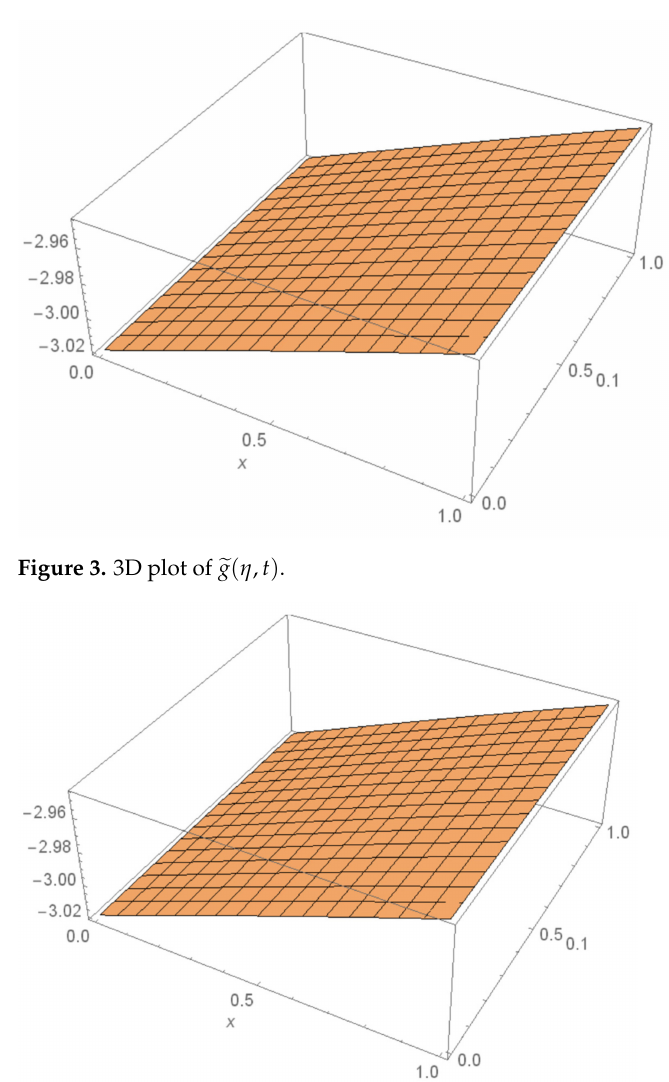
Figure 2. 3D exact solution of f ( η , t ) .